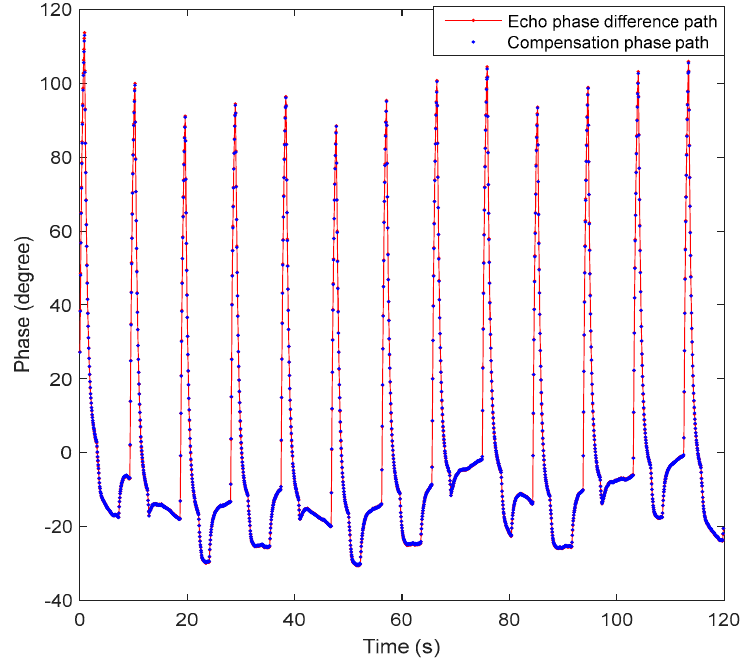
Figure 9. The echo phase difference and compensation phase of the two satellites .